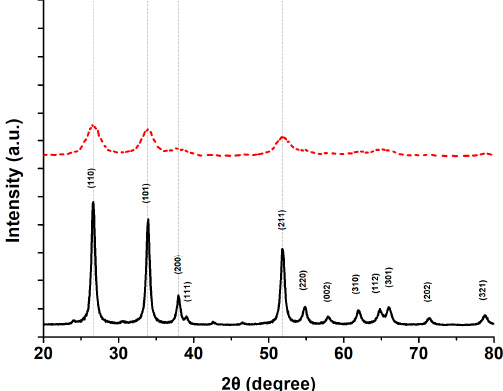
Figure 2. X-ray diffraction patterns of intact SnO 2 (black line) and SO 42 − /SnO 2 (red dashed line). The samples were calcined at 550 °C. On the basis of the ICDD powder diffraction file (PDF 00-041-1445), the peaks were indexed as tetragonal crystal structure as cassiterite SnO 2 (P4 2 /mnm space group).